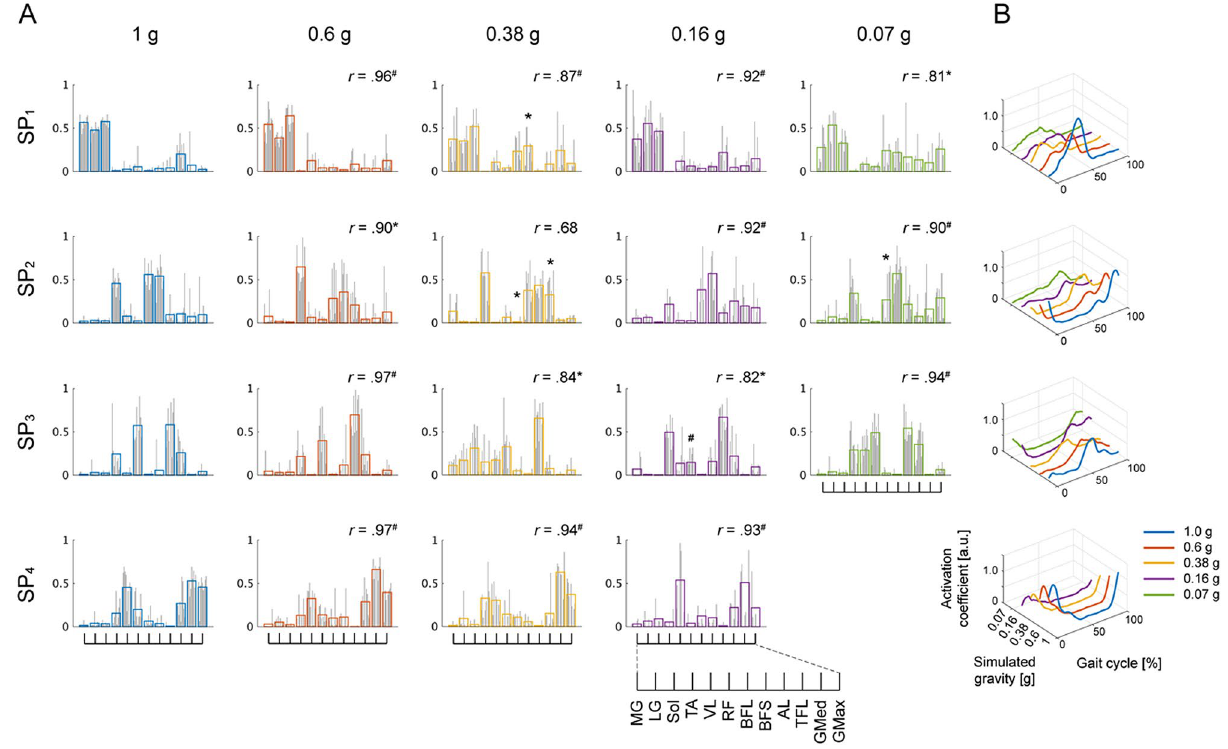
Figure 5. Modules clustered based on the spatial modules. Modules extracted from the EMG data matrix at Fr ~ 0.25 are shown. ( A ) The bar graphs represent weighting vectors for each muscle, i.e., a spatial module. Spatial modules identified from all participants were classified into a set of 4 clusters in each gravity level. The grey individual bar graph indicates a spatial module identified in each participant, and the coloured solid bar graph indicates the average over participants. ( B ) The line plots indicate the amplitude of the activation coefficient, i.e., a temporal module, averaged across participants. The different columns of the spatial modules and different colours of the temporal modules denote the 5 different gravity levels. The spatial modules corresponding to the same cluster, i.e., SP 1 to SP 4 , and the corresponding temporal modules are arranged in the same row. The similarity of the spatial modules between the gravity condition of 1 g and each of the other gravity levels in each cluster (SP 1-4 ) is shown as the cosine similarity ( r ). Symbols (*, #) indicate a significant difference in the weighting vectors of all or each muscle; * p < 0.05 and # p < 0.01.